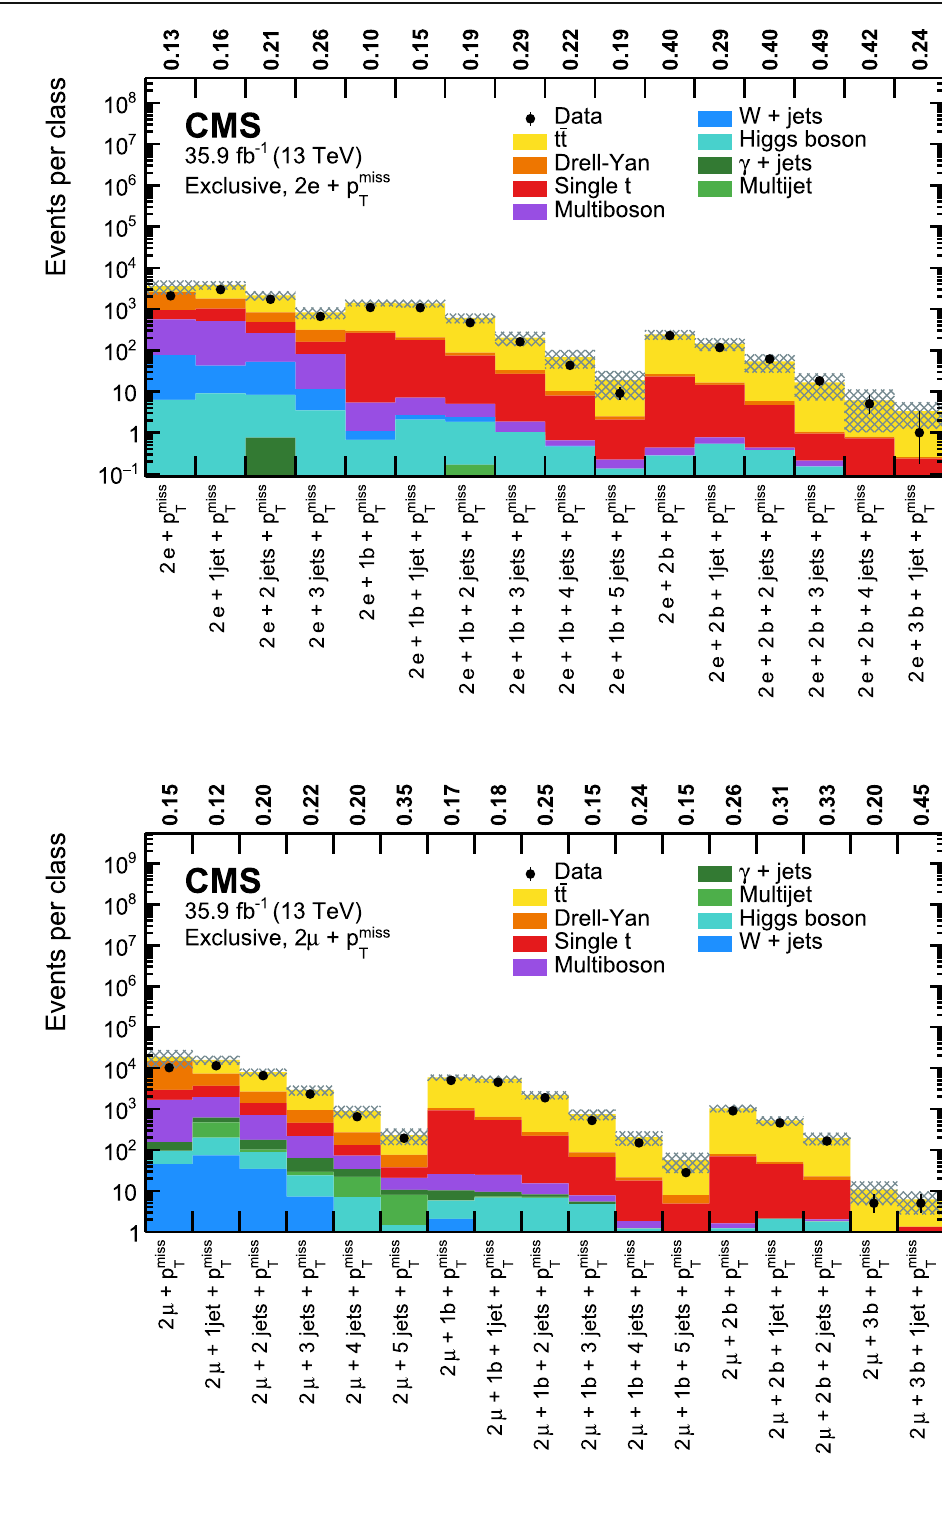
Fig. 18 Overview of total event yields for the event classes of the double-electron + p miss (upper) T and the double-muon + p miss T (lower) object groups. Measured data are shown as black markers, contributions from SM processes are represented by coloured histograms, and the shaded region represents the uncertainty in the SM background. The numbers above the plot indicate the observed p value for the agreement of data and